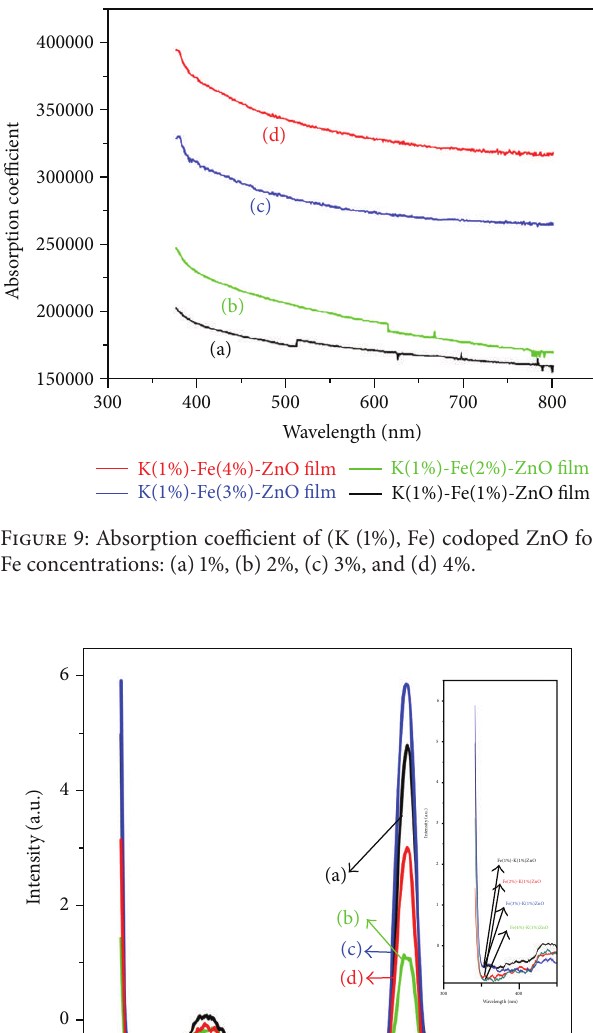
films exhibit significant changes and are also suitable for integrated optical device application. The normal dispersion indicates that the films do not have voids or any defects. The lower values of extinction coefficient indicate the smoothness of the thin